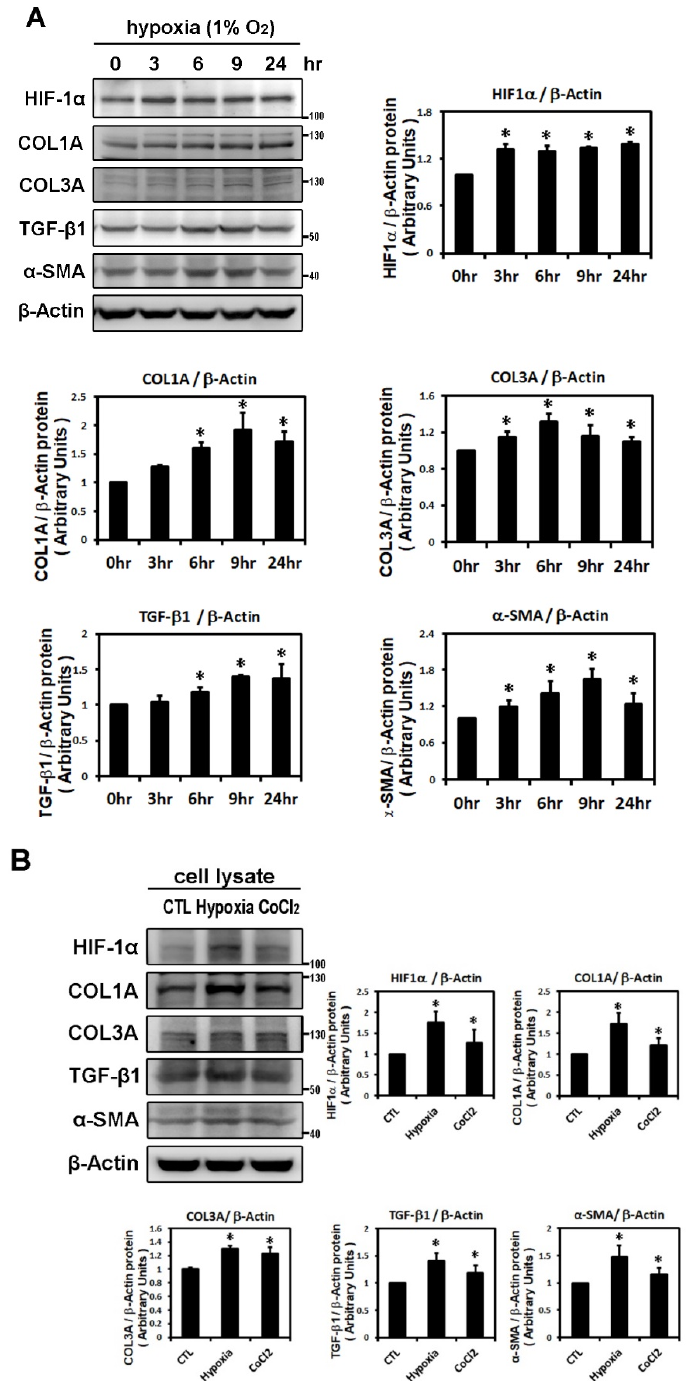
Figure 1. Effects of hypoxic treatment on the expression of HIF-1 α and profibrotic proteins. Expression of the indicated proteins in cellular homogenates was measured by Western blot. Each lane contained a total of 25 μ g of protein and the blots were probed with the indicated antibody. All data were normalized to the β -actin loading and blotting control. Bar graphs indicate band intensity as determined by densitometry and the fold increase in intensity over control. Panel A : Exposure of cultured HL-1 cells to hypoxia (1% O 2 ) for the indicated times resulted in time-dependently increased protein levels of HIF-1 α (maximum reached at 3 h), COL3A (maximum reached at 6 h) and TGF- β 1, α -SMA, COL1A (maxima reached at 9 h). Panel B : Representative Western blots and quantitative analysis of protein levels of HIF-1 α and fibrosis-related proteins (COL1A, COL3A, TGF- β 1, α -SMA) in HL-1 cells treated with hypoxia (1% O 2 ) or CoCl 2 (10 − 4 M) for 6 h. The data are mean ± SEM ( n = 4 per group, * p < 0.05 vs. control) from four independent experiments.